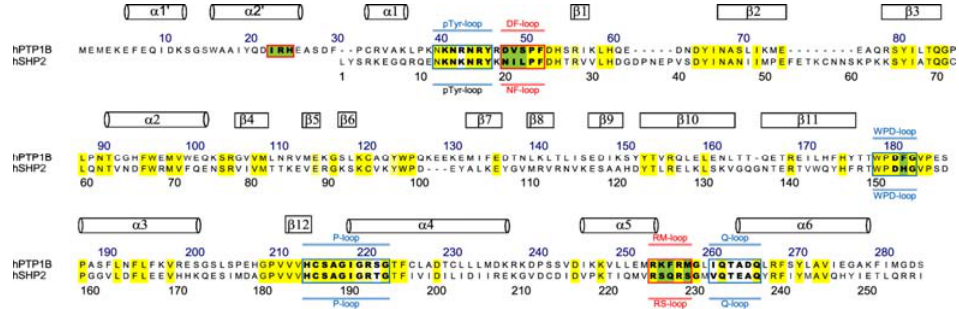
Figure 5. Sequence alignment of PTP domains between PTP1B and Src homology 2 (SH2) domain-containing phosphatase 2 (SHP-2). The catalytic site and site B regions are boxed with blue and red lines, respectively. In this article, single letters with yellow and green squares indicate the conserved residues and non-conserved residues involved in the definition of substrate selectivity-determining regions. Residue numbers for PTP1B and SHP-2 are shown above and below the alignment,